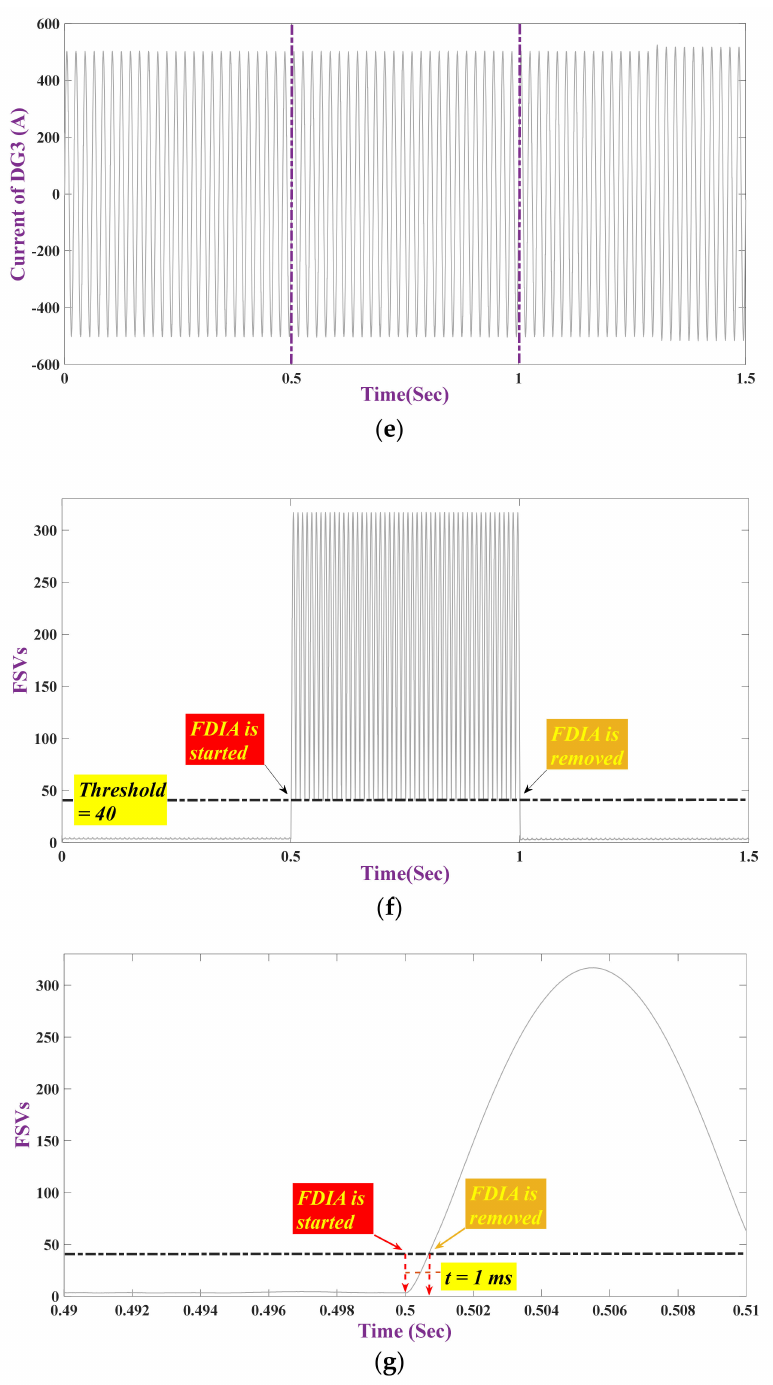
Figure 11. Instability stems from manipulating on current sensor: Manipulating shared current between agent II and III: ( a ) ISMG’s voltage; ( b ) Loads current; ( c ) Current waveform of DG 1 ; ( d ) Current waveform of DG 2 ; ( e ) Current waveform of DG 3 ; ( f ) FSVs of signals; ( g ) Time response of FSV’s scheme (FDIA is initiated at t = 0.5 s and is omitted at t = 1